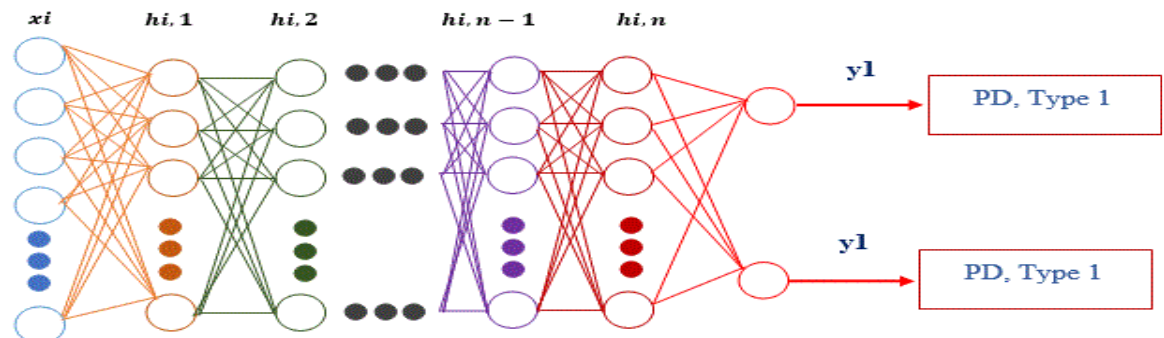
Figure 18. Autoencoder architecture.